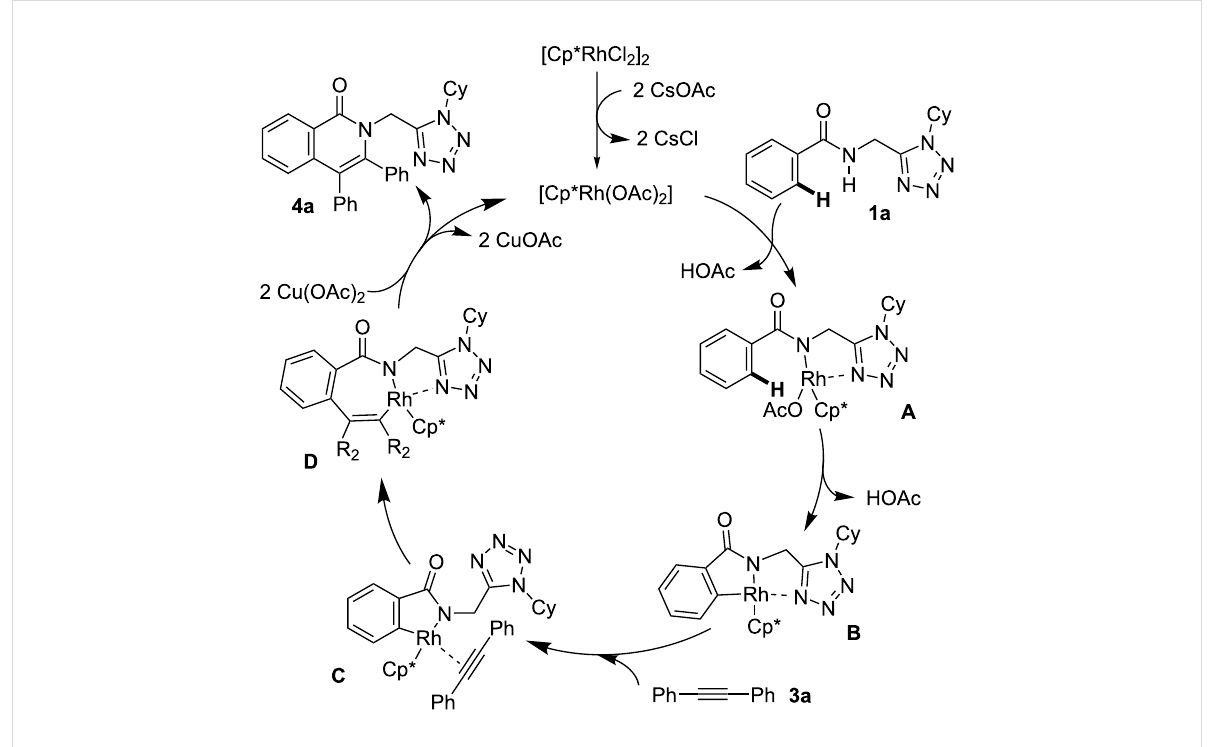
Scheme 6: Proposed reaction mechanism using substrates 1a and 3a